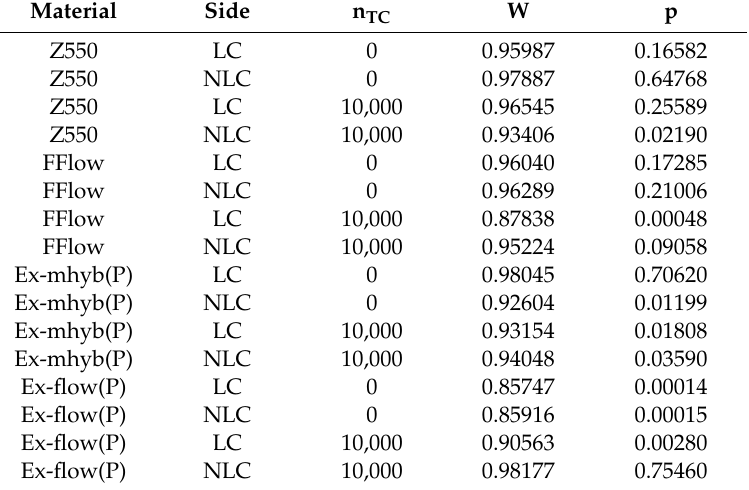
Table 1. Shapiro–Wilk test values for normal distribution for Vickers hardness results. Values of p < 0.05 are marked in